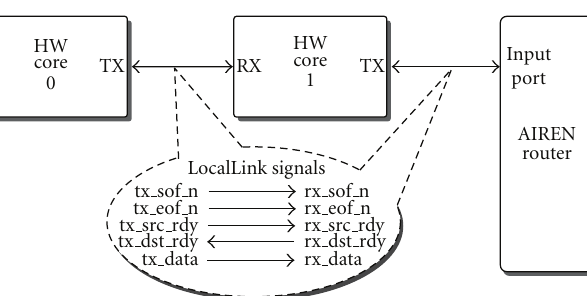
Figure 3: Simple illustration to show the Xilinx LocalLink standard implemented within the AIREN network to support both core-to-core and core-to-router